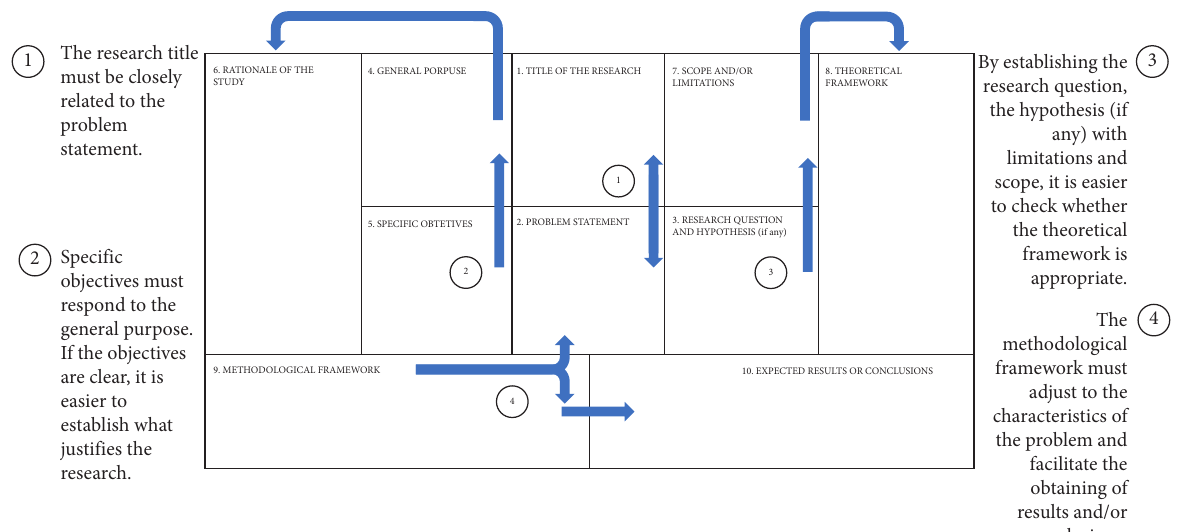
Figure 5: Relationship among the boxes of the Canvas Model for Research Projects (CMRP). Elaborated by F´elix Socorro. November